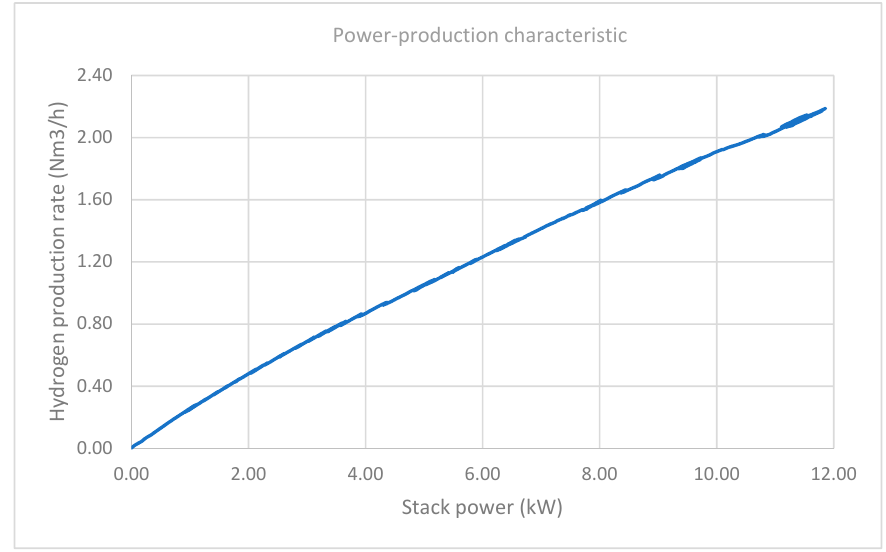
Figure 17. Experimental results. Relationship between stack power consumption and hydrogen production rate.